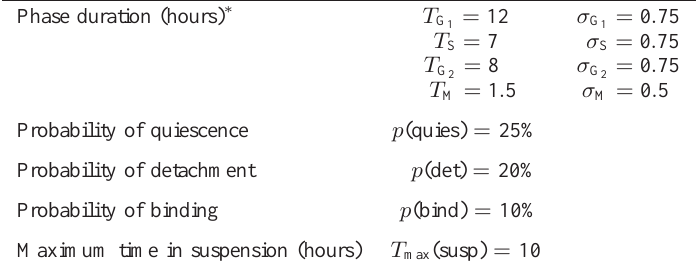
Table 1 Values adopted for the parameters of the